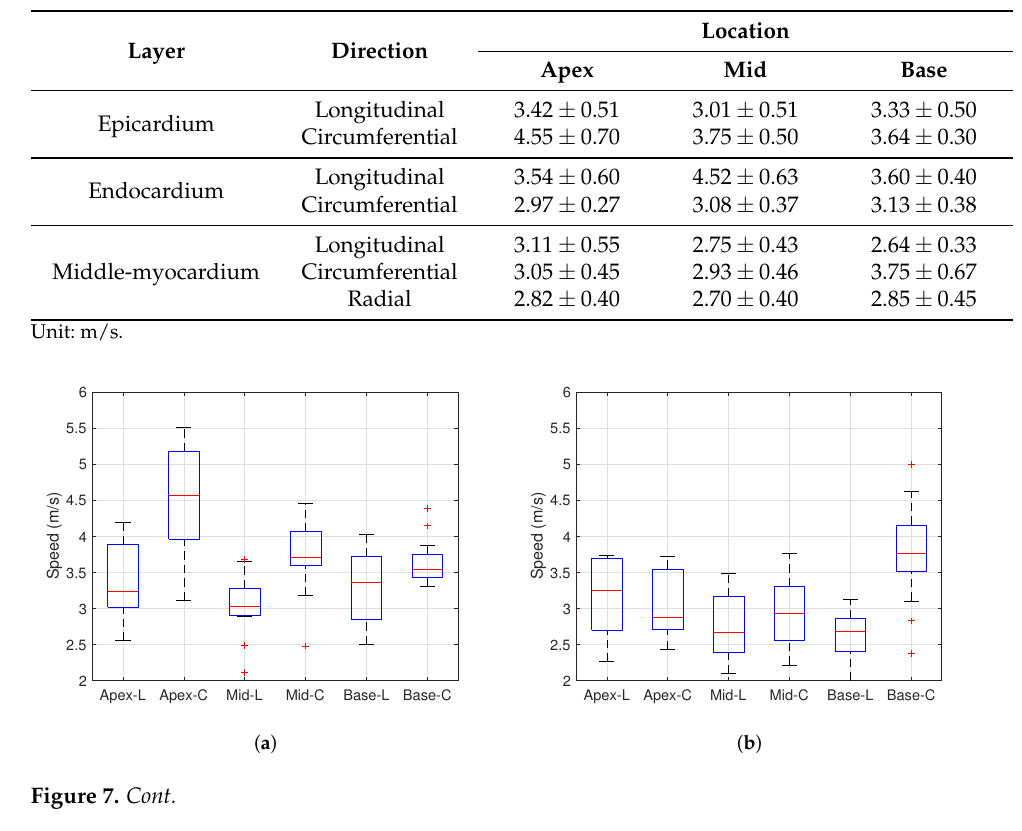
Table 1. Experimental results: wave speed in swine hearts.